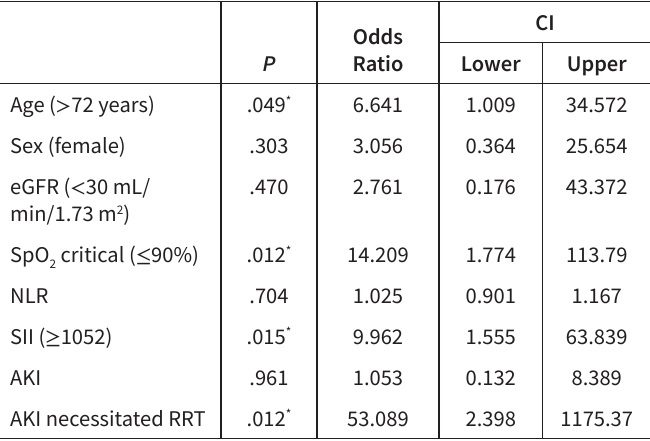
Table 5. Logistic Regression for Risk Factors Associated